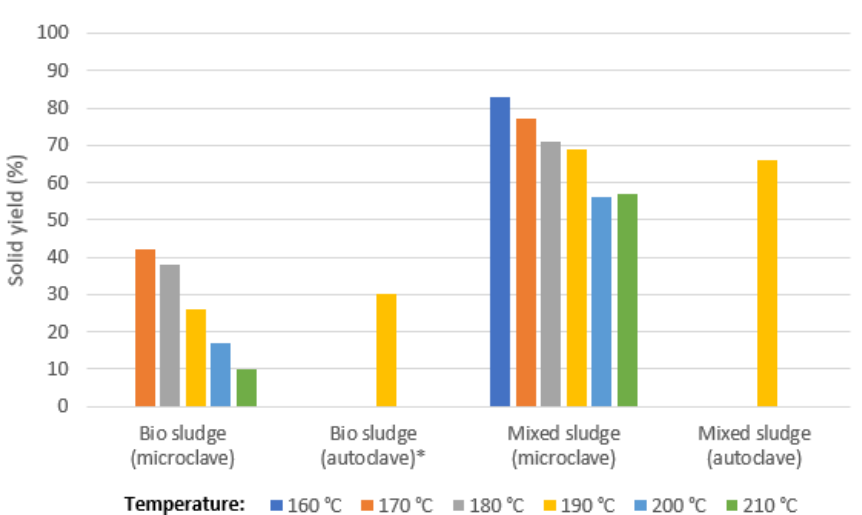
Figure 3. Solid yield of the press cakes from the obtained product slurry from bio-sludge and mixed sludge after mild hydrothermal carbonization at different temperatures and carver die dewatering. * Second batch of bio-sludge.